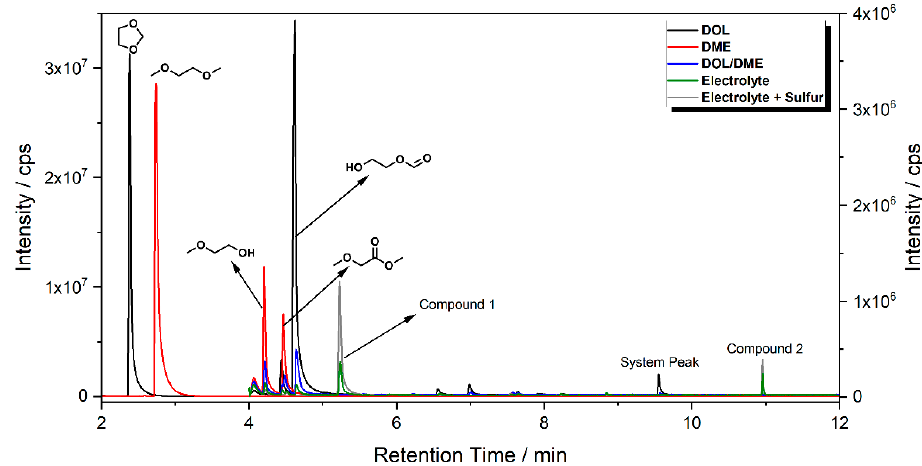
Figure 1. Overlay of the GC-MS chromatograms obtained from ethers and ether-based electrolytes stored at elevated temperatures. Excerpt from 2–4 min extracted from measurements with 1:100 split ratio. Chromatograms from 4 min were obtained with a lower split ratio of 1:10. Both ether solvents are accessible by GC-MS and are the main components in all cases.